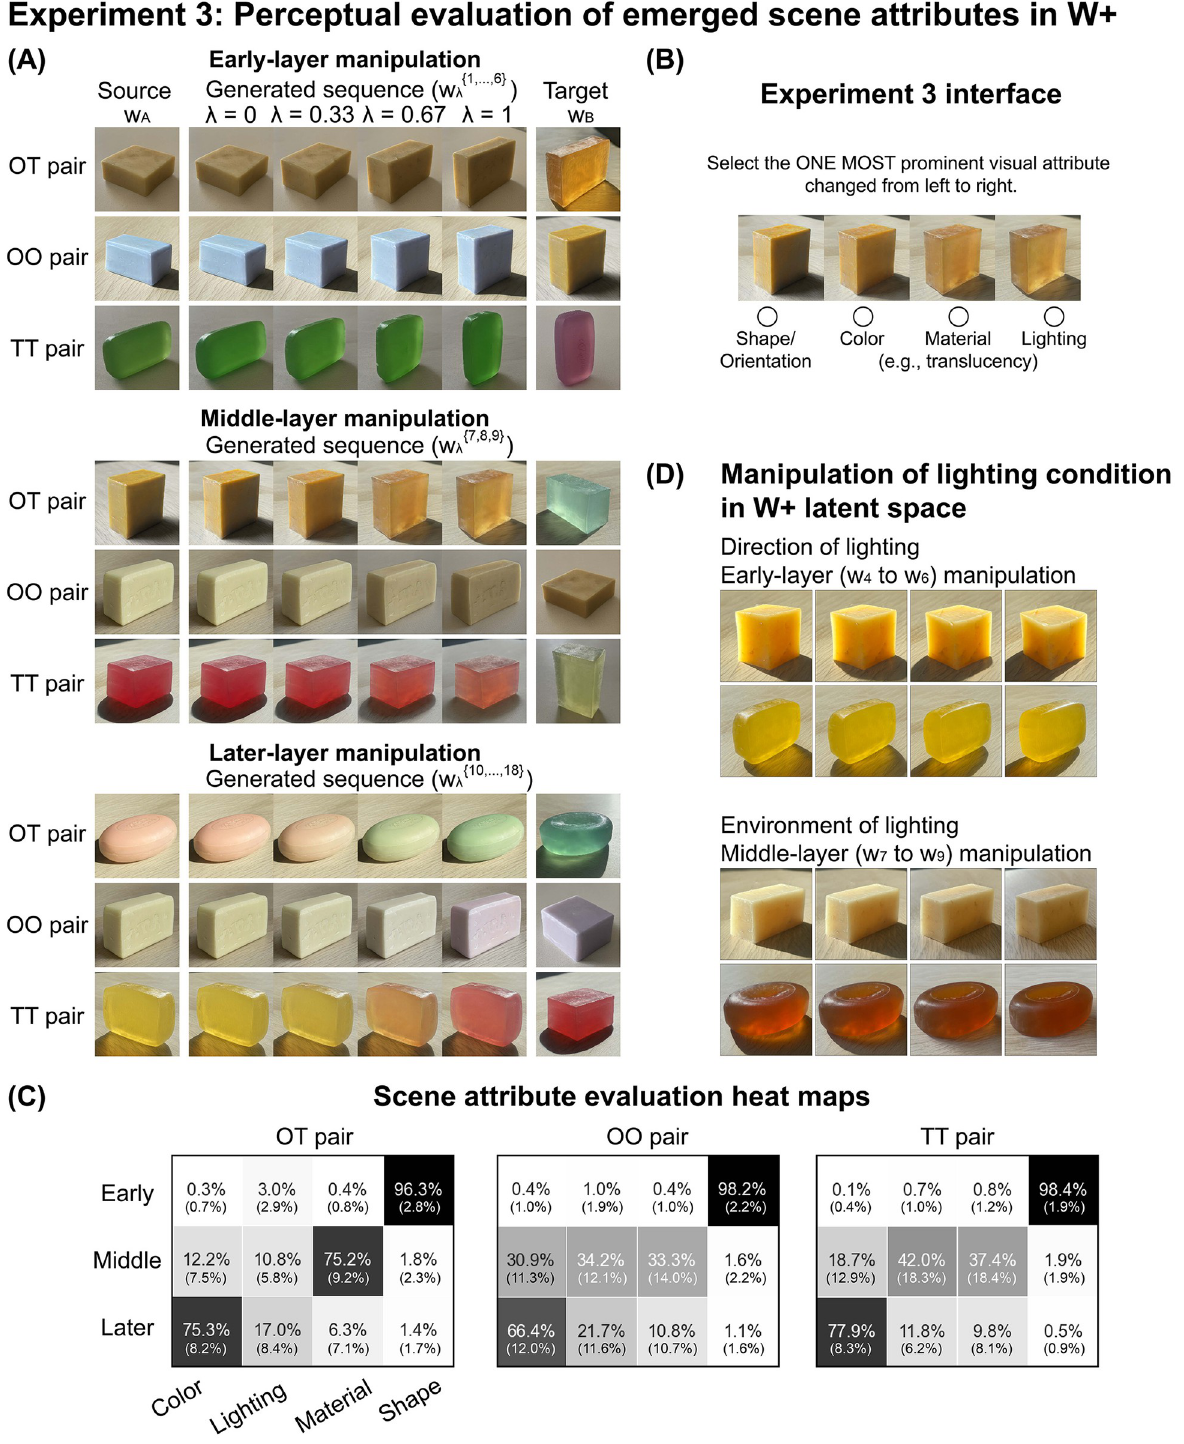
Fig 4. Experiment 3: Perceptual evaluation of emerged scene attributes in the layer-wise latent space. (A) Examples of morphed image sequences used in Experiment 3, generated by linearly interpolating between the latent codes of source ( w A ) and target ( w B ) separately at the early ( w 1 to w 6 ), middle ( w 7 to w 9 ), and later-layers ( w 10 to w 18 ). The λ is the interpolation step from the source image in the linear interpolation. Source- target pairs were picked under three conditions based on soap’s material properties: opaque-translucent (OT), opaque-opaque (OO), and translucent-translucent (TT). (B) The user interface of Experiment 3. (C) The perceptual results on how different layers correspond to